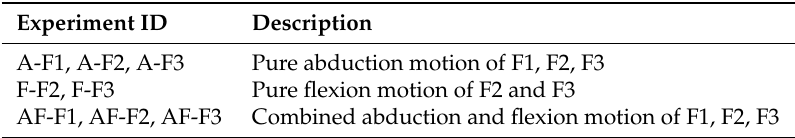
Table 4. Overview of experiments in Setting 1 with optical reference (A: abduction, F: flexion, AF: abduction and